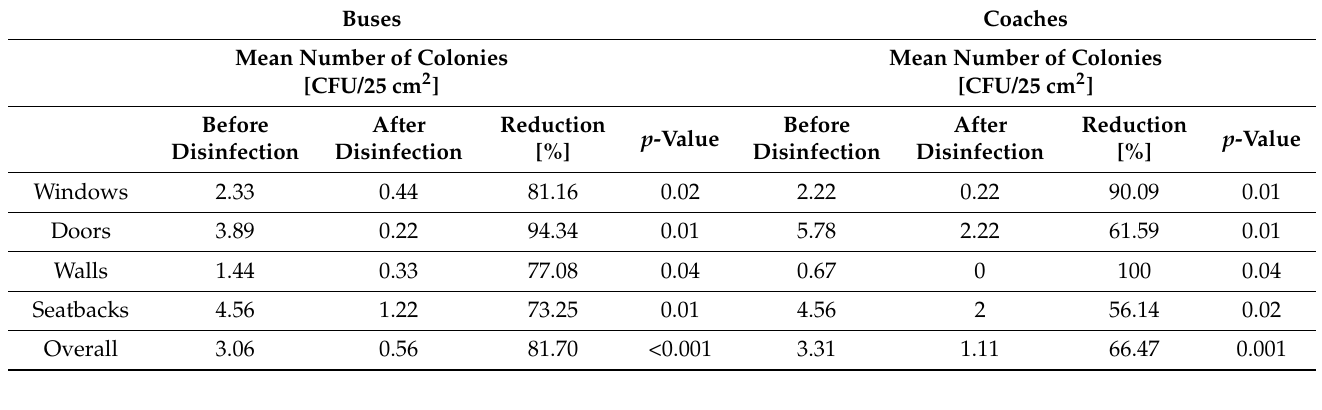
Table 3. Disinfection effect on various surfaces in buses and coaches.